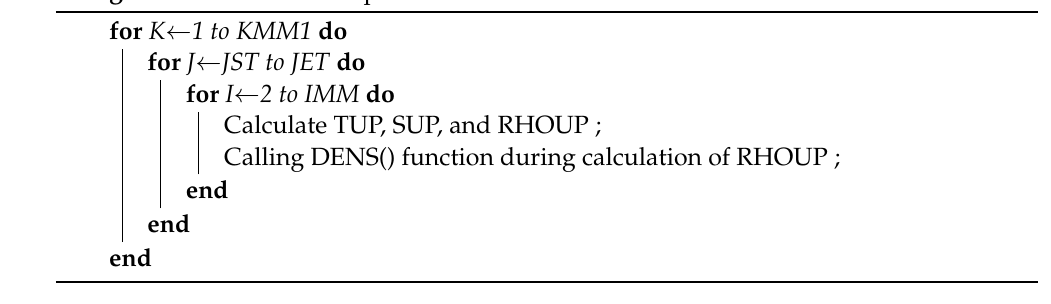
Algorithm 6: Function Expansion A